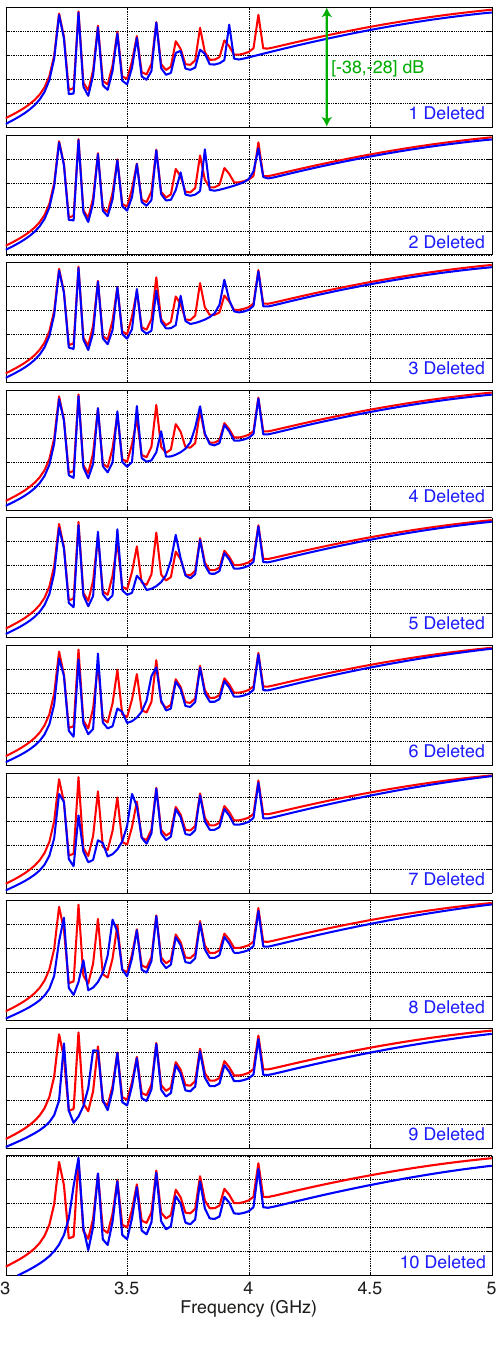
Figure 3: Electromagnetic responses of RFID tags that are obtained by deleting single bits from the overall structure in Fig. 1.